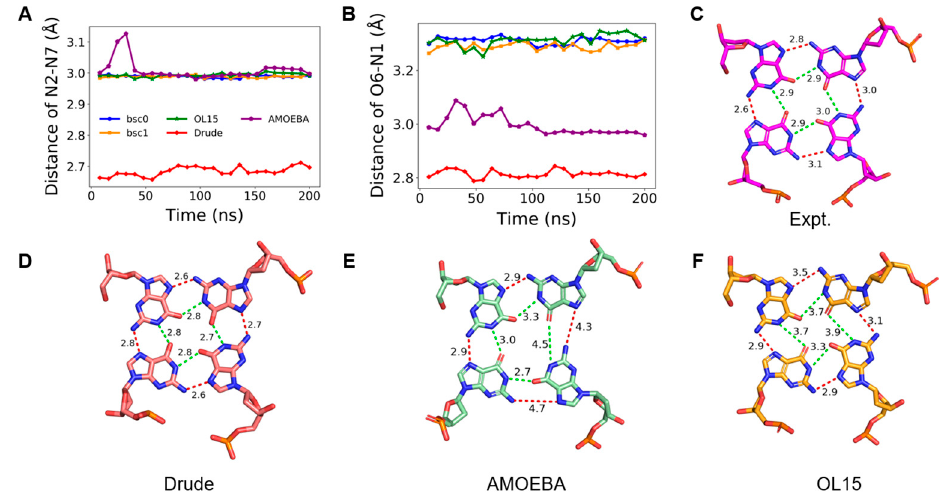
Figure 5. ( A , B ) are changes of hydrogen bond lengths in tetrad 1 during the MD simulation of Na-GQ. ( C – F ) are typical structures of tetrad 1 in experiment, and MD simulation with Drude, AMOEBA, and OL15, respectively. ( A , B ) share the same figure legend.